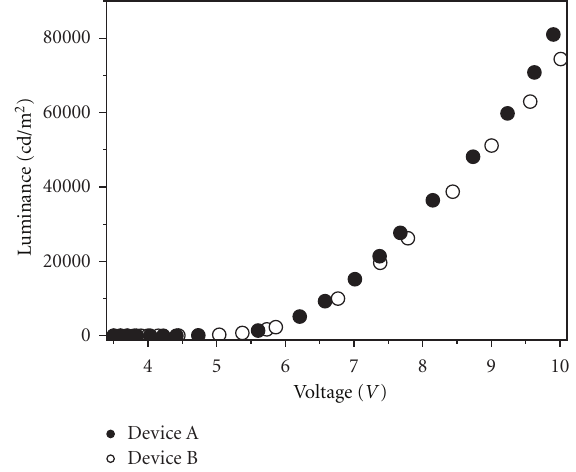
Figure 3: The luminance-voltage characteristics of Devices A and